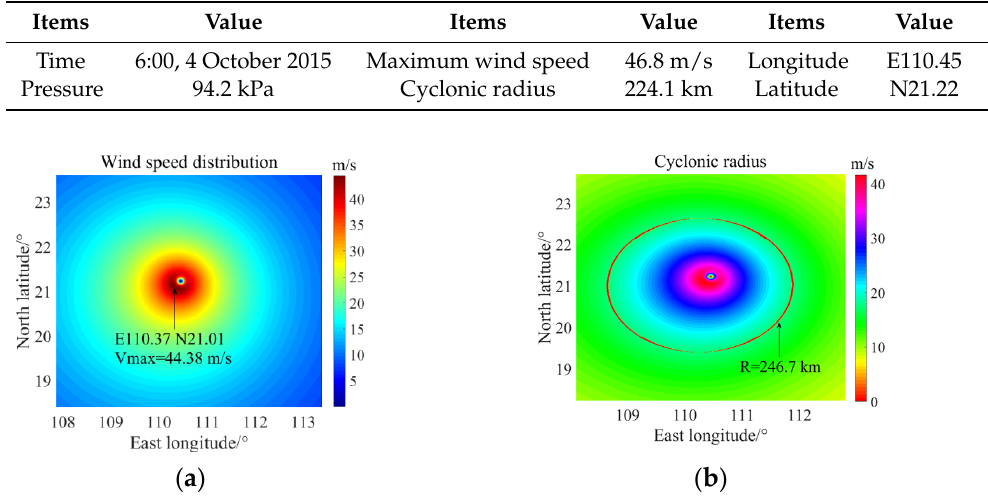
Figure 5. The simulation wind field: ( a ) Wind speed distribution; ( b ) Cyclonic radius.